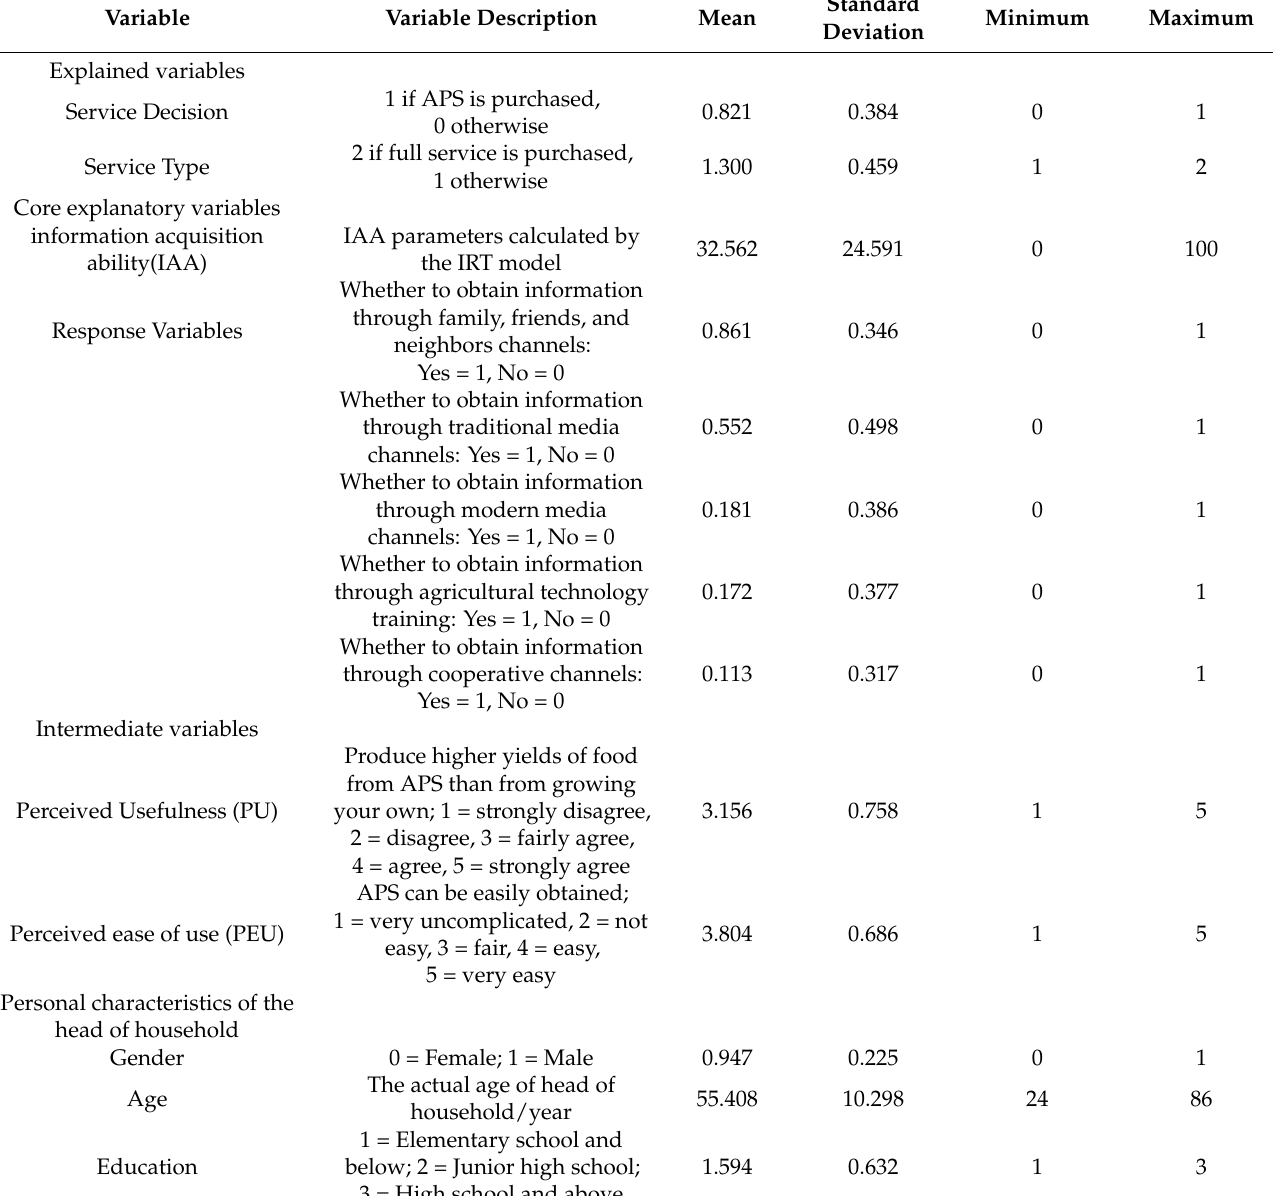
Table 2. The meaning of each variable and the results of descriptive statistical